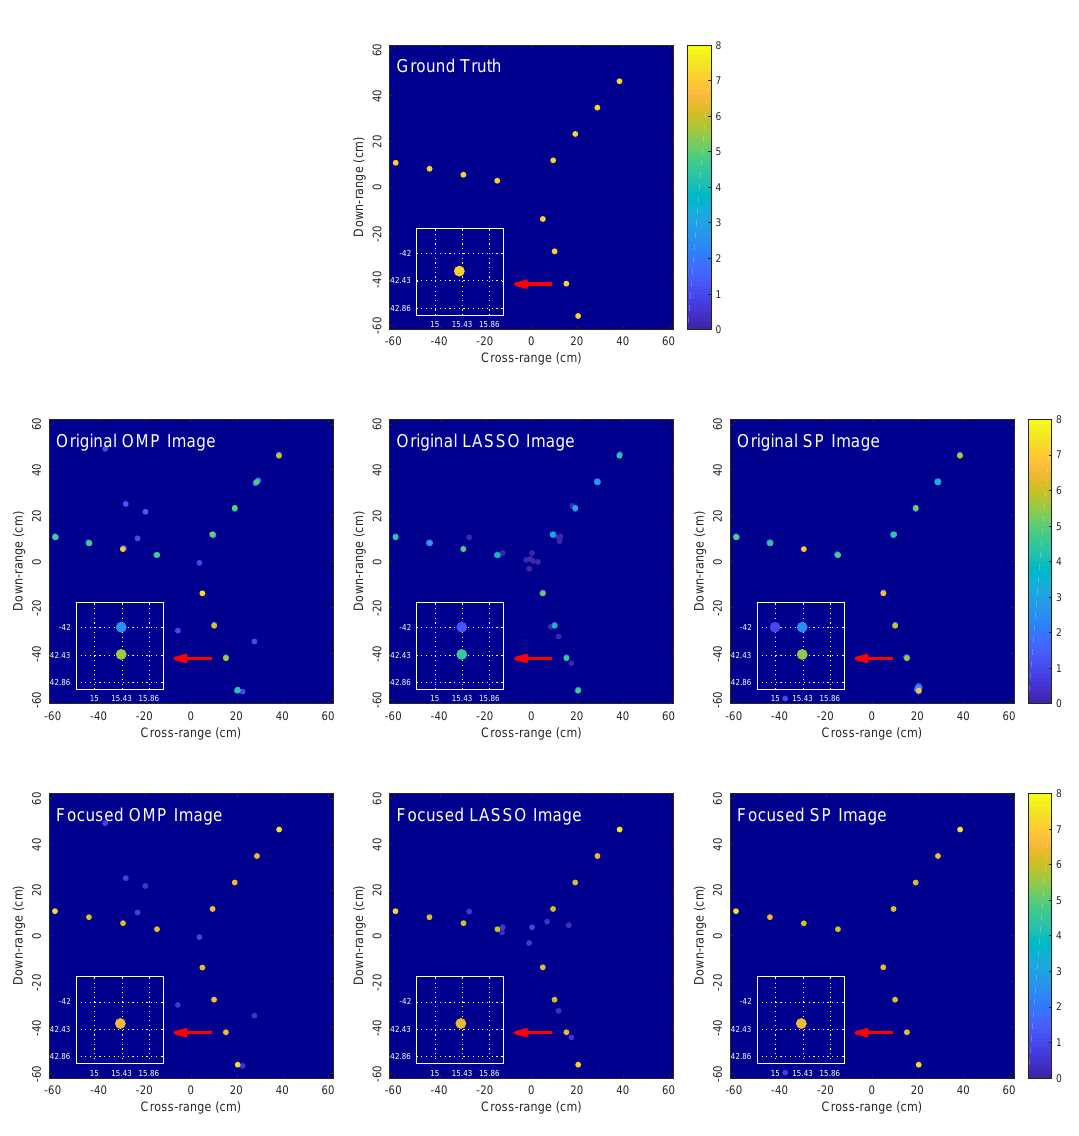
Figure 6. Comparison of the original OMP, LASSO and SP images and the corresponding focused images obtained by the proposed algorithm for Target 1. In the zoomed-in images, dictionary grid points are located at intersections of dotted